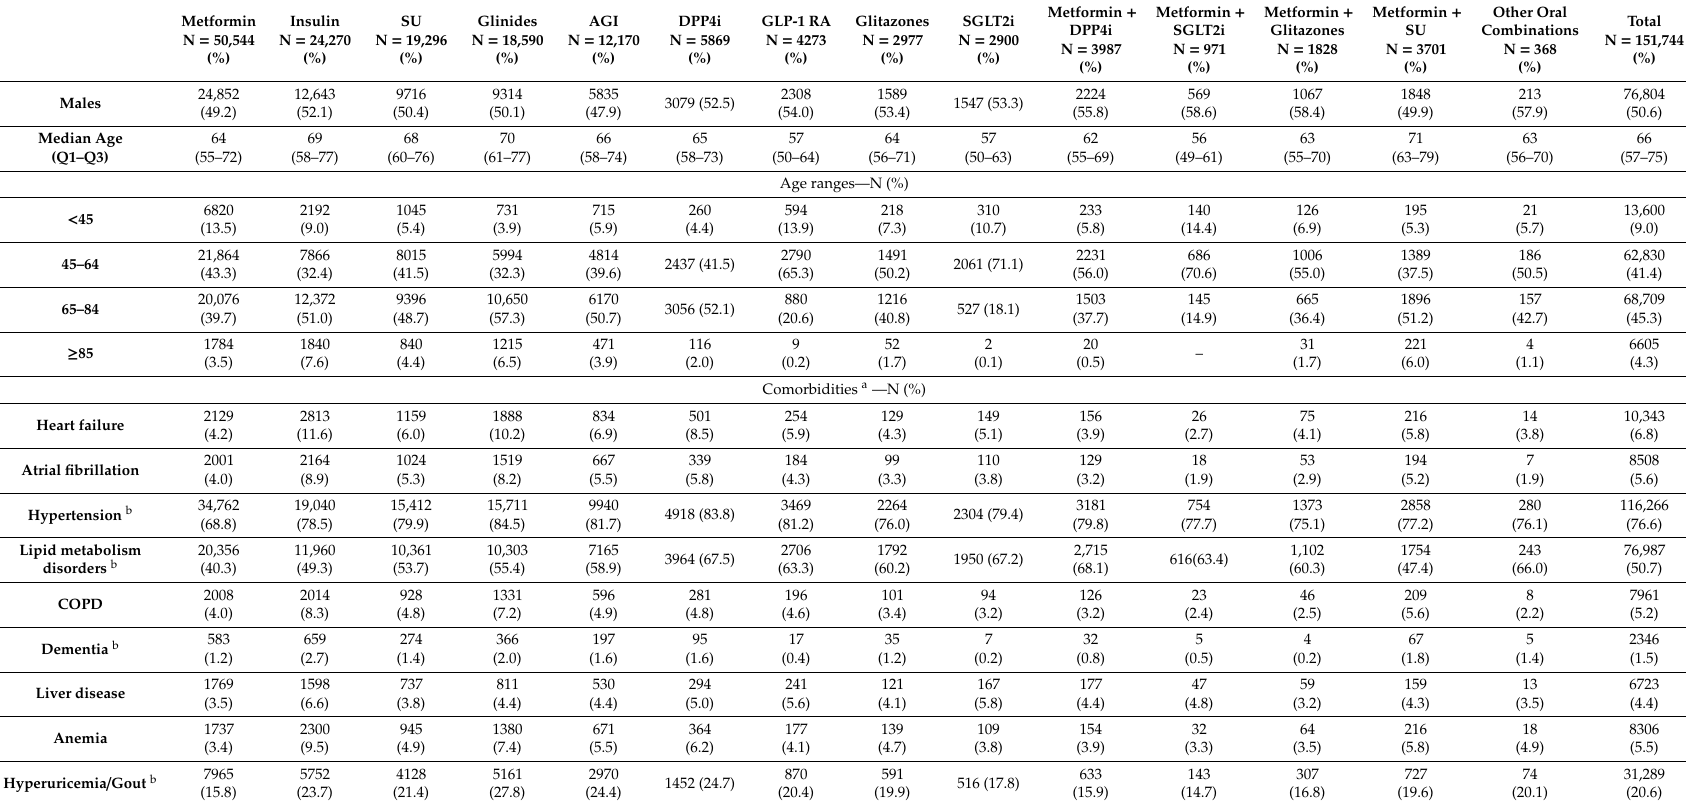
Table 1. Baseline characteristics of incident AD treatments in Palermo LHU during the years